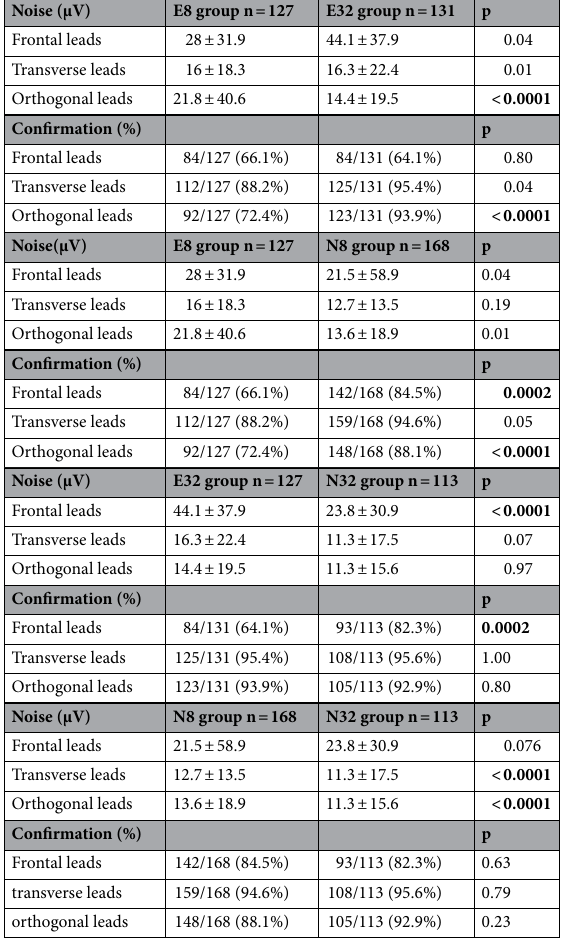
Table 4. Noise values and confirmation during the maximum TWA moment, according to set of leads in the different groups. Noise values are expressed as mean and standard deviation. Groups: E8 = Ellestad factor 1/8; E32 = Ellestad factor 1/32; N8 = Naughton factor 1/8; N32 = Naughton factor 1/32. Data presented as Mean ± Standard Error. Bold values indicate statistical significance. Significant p-value considered 0.0083 (Bonferroni’s